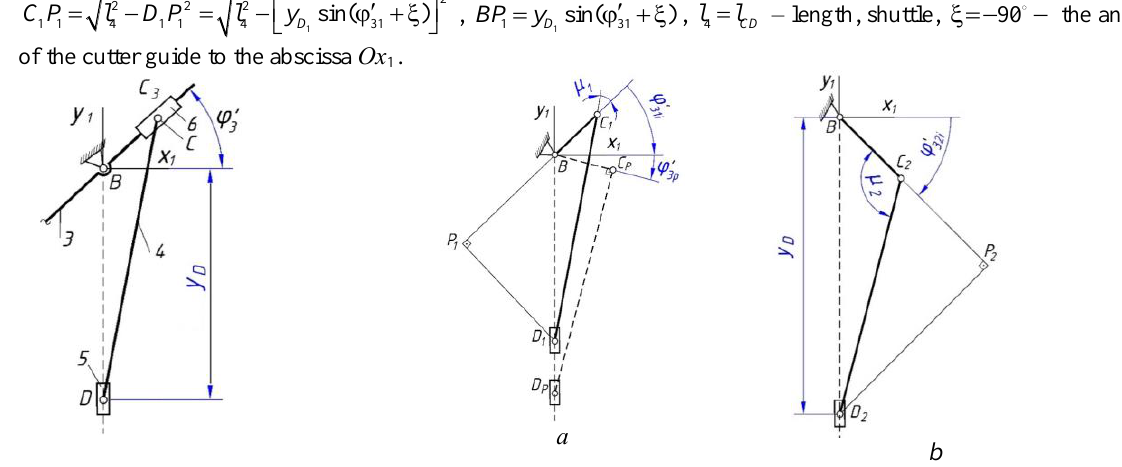
Fig. 5. For the determination of the length of the of the conditional crank